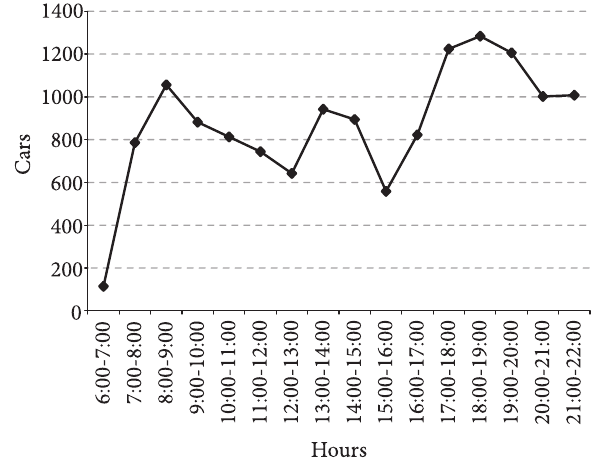
fig. 4. Dynamics of transport flows in Vokiečių